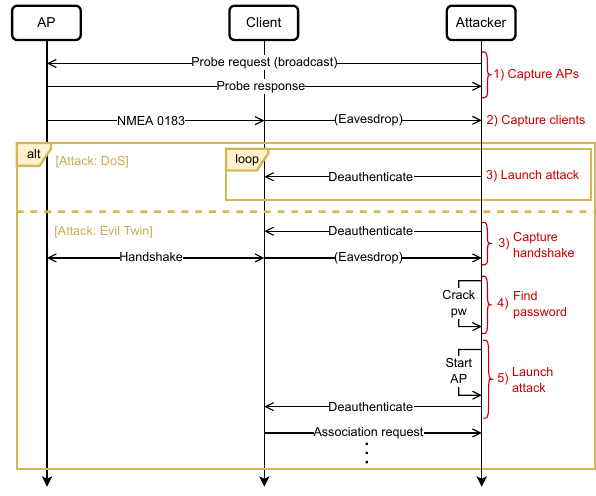
Figure 14. Sequence diagram of DOS and Evil Twin